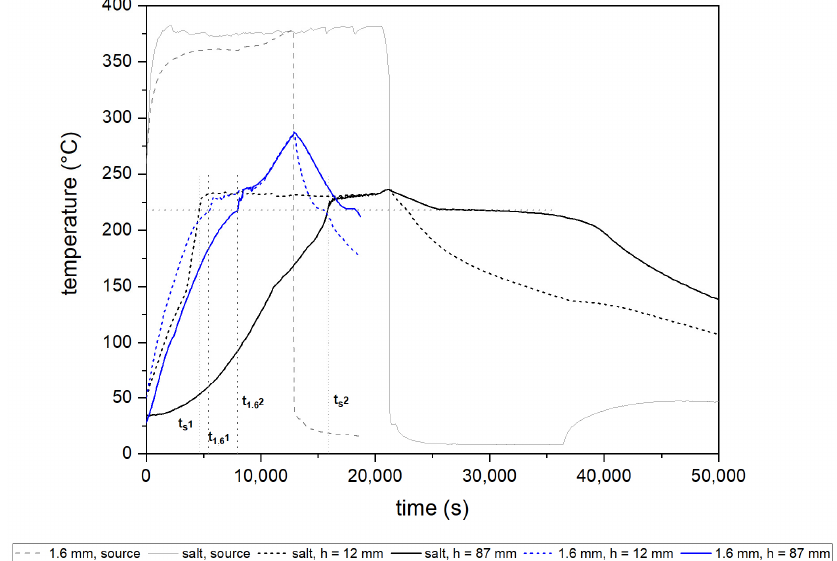
Figure 5. The temperature change in the deposit during the heating and cooling of the store: containing pure PCM and the one with honeycomb heat transfer enhancer with a wall thickness of 1.6 mm. Table 3. Starting time of the deposit’s melting at the height of the bottom (h = 12 mm) thermocouple (t 1 ) and the top (h = 87 mm) thermocouple (t 2 ) and the calculated duration of the deposit’s melting (delta) for the tested cases: a pure mixture of salts, PCM, and an insert with a wall thickness of 1.2 mm, and a PCM insert with a wall thickness of 1.6 mm.